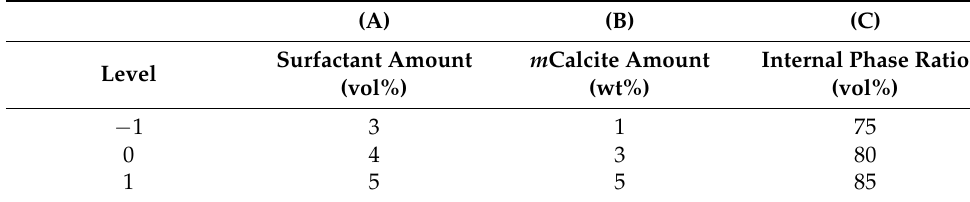
Table 1. Experimental parameters and factor levels.